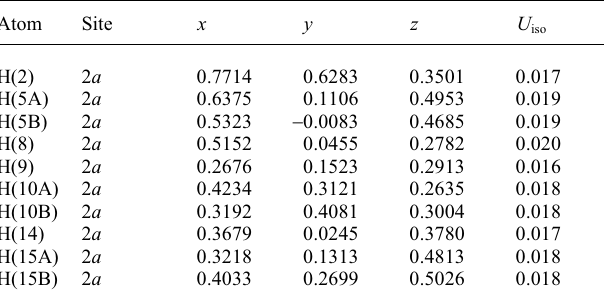
Table 2. Atomic coordinates and displacement parameters (in Å 2 ) .